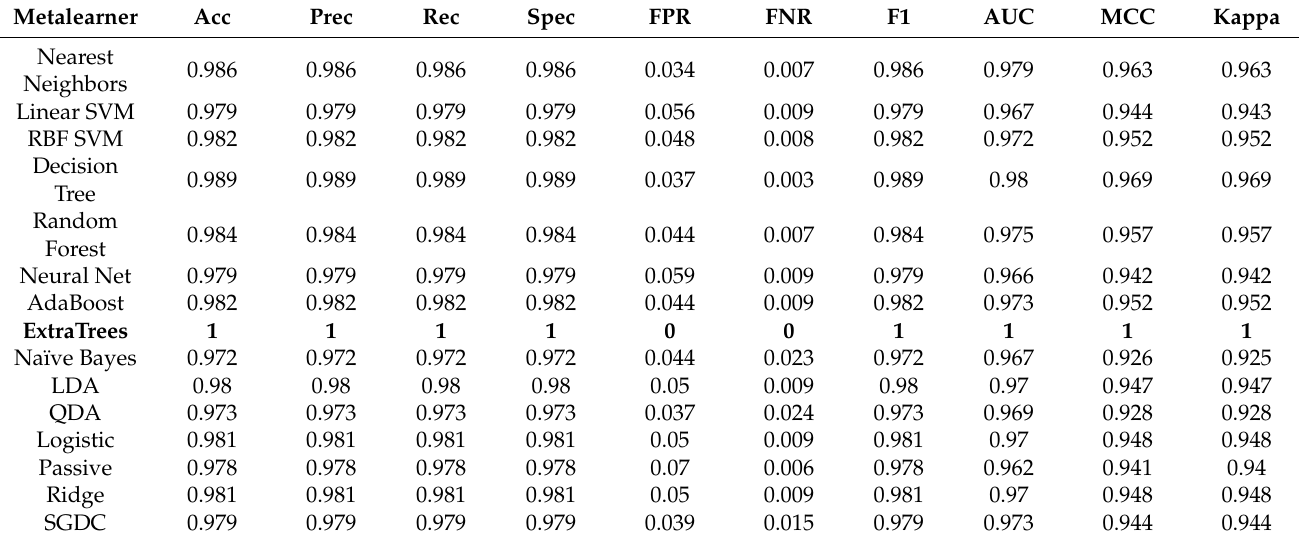
Table 7. Average ensemble learning results from 10-fold cross-validation. Best values are shown in bold.